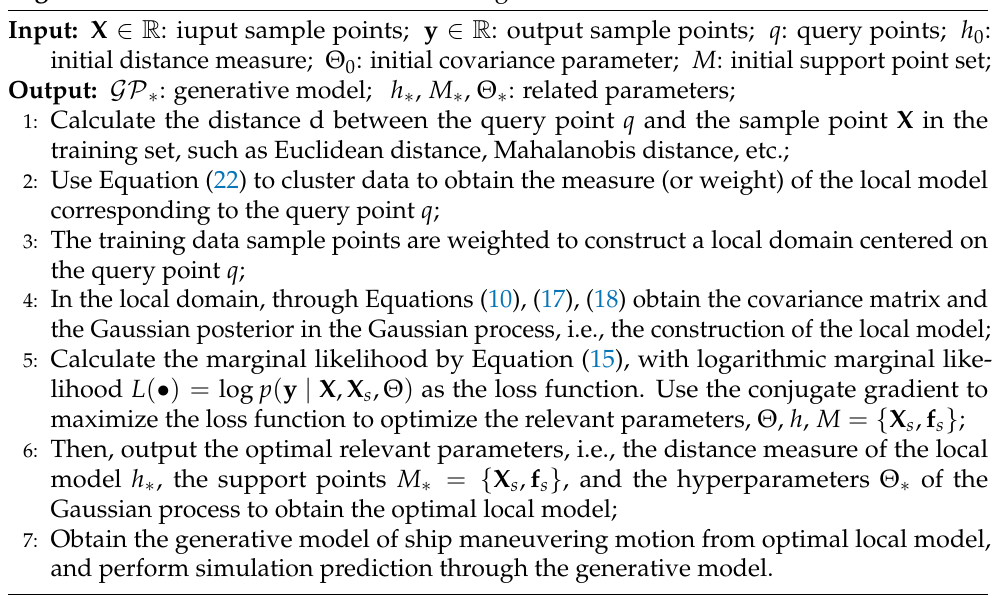
Algorithm 1 Localization and model learning of